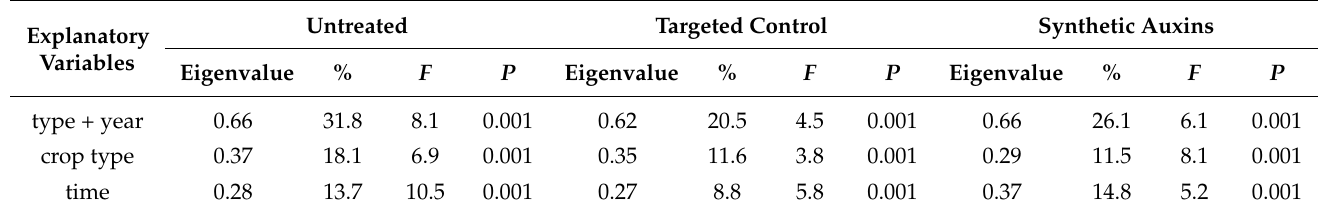
Table 6. Net effects of explanatory variables on weed species composition in Pernolec for simple rotation. Partial CCAs were used when gradient length > 3.0. Eigenvalue = sum of all canonical eigenvalues (total inertia = 2.07); % = percentage of explained variance; F = ratio for the test of significance of all canonical axes and p -value = corresponding probability from the Monte-Carlo permutation